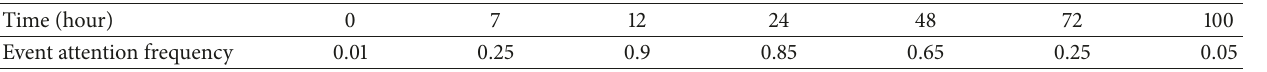
Figure 6: Table function representation of each variable (event attention shown in (a); government reporting frequency shown in (b); policy frequency shown in (c); mass discussion shown in (d)). Table 2: Table function of event attention.